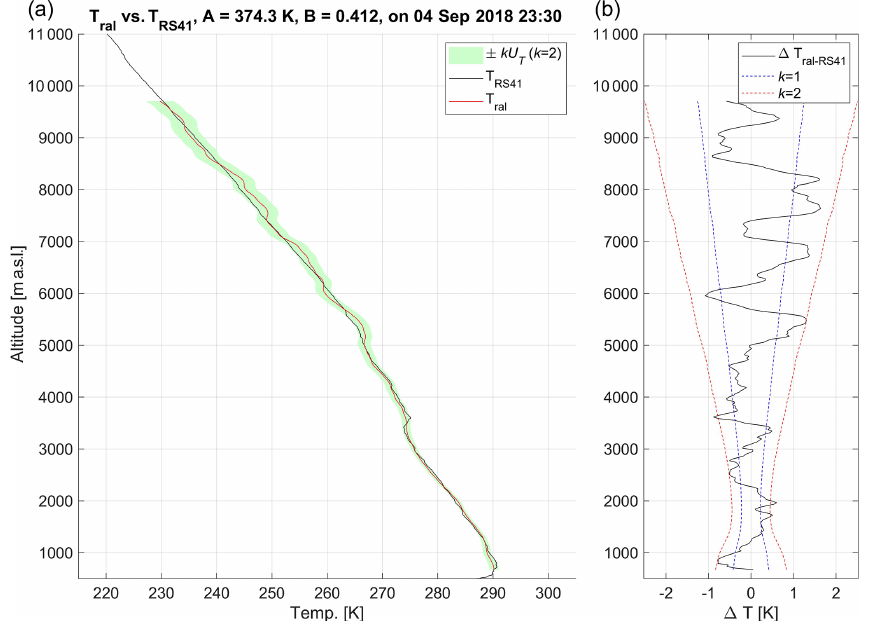
Figure 9. RALMO temperature profile calibrated by the ORS RS41. Panel (a) shows T RS41 (solid black) and T ral (solid red) with the confidence interval (green shading) corresponding to kU T (k = 2 ) . Panel (b) shows the differences (cid:49)T ral − RS41 within the U T k -boundaries for k = 1 (dashed blue) and k = 2 (dashed red). Table 4. Calibrations of RALMO T profiles by the working standard